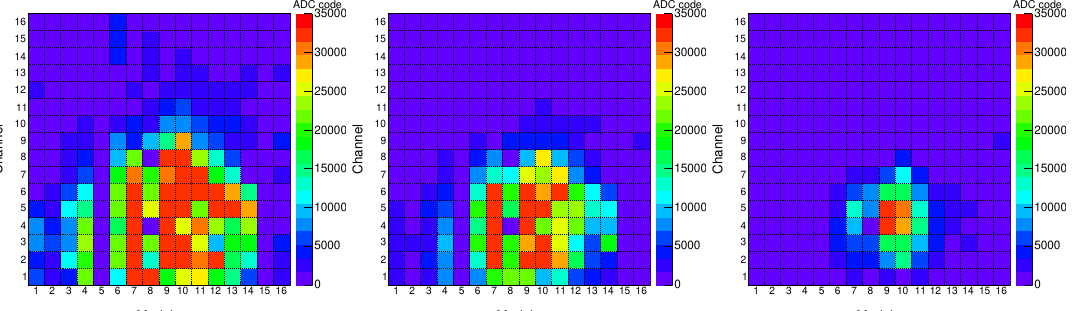
Figure 10. Snapshots of the focal plane for the event presented in Figure 9. Snapshots were made at t = 10 ms, 40 ms, and 88 ms from the beginning of the record. Colors denote ADC counts. A comparison with the Vaisala global lightning data set GLD360 was made for this